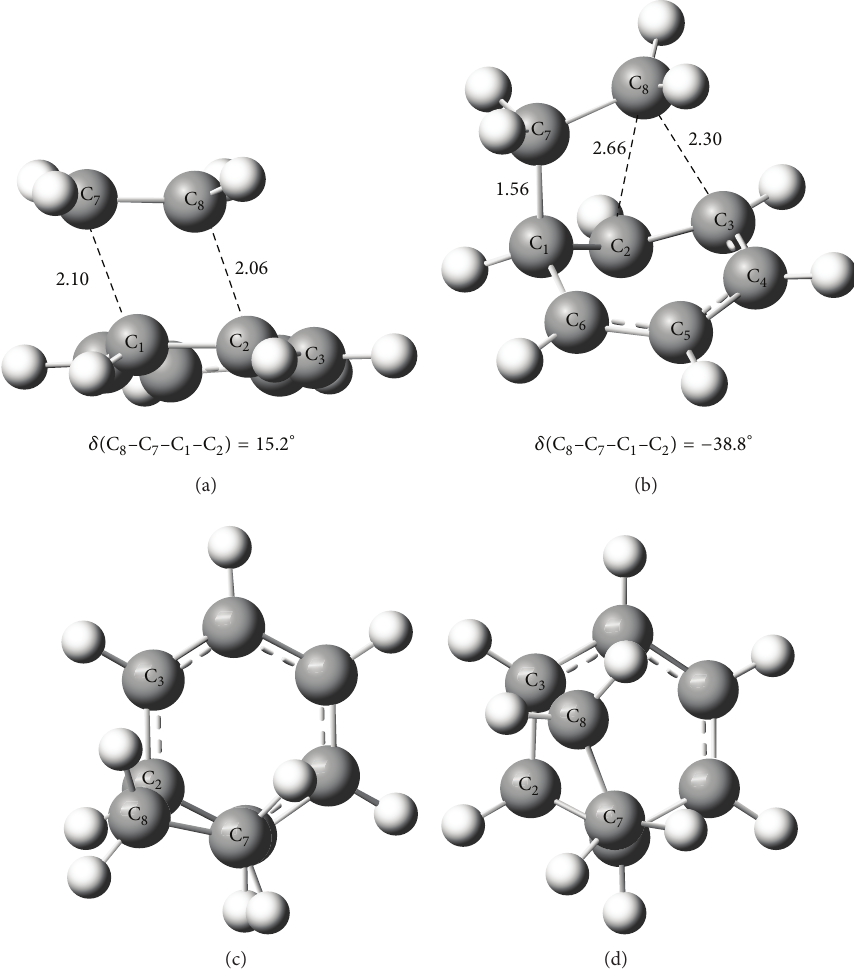
Figure 10: Optimized geometries of S 1 /S 0 conical intersection of (a) synchronous and (c) asynchronous mode at CASSCF (8,8)/6-31G(d) level. (b) and (d) are top view of (a) and (c),